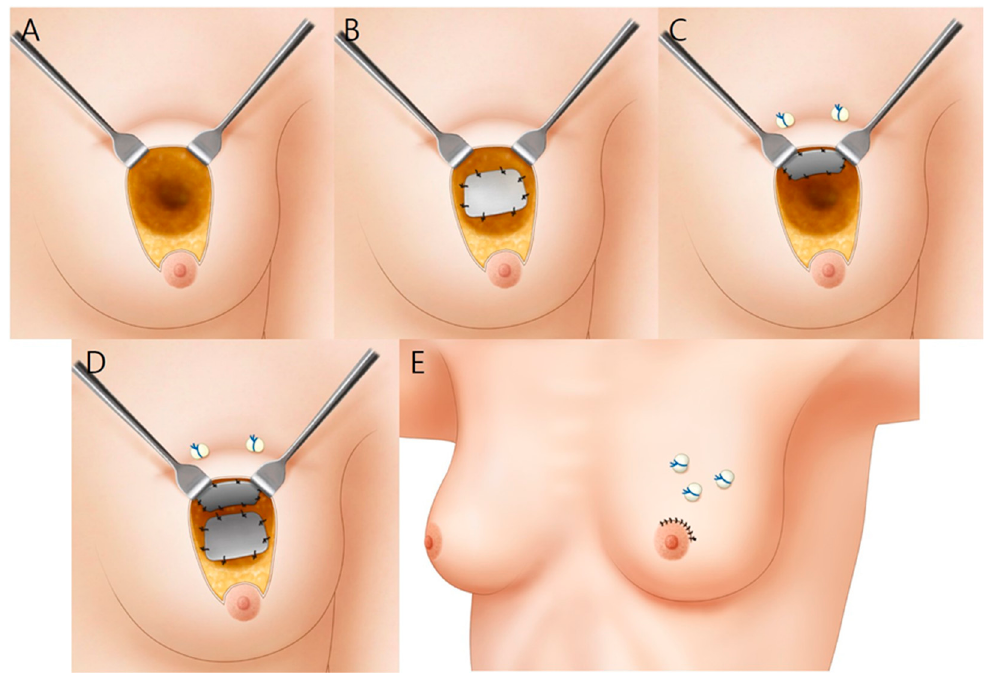
Figure 1. A schematic illustration summarizing the surgical procedure. ( A ) The glandular tissue is exposed after partial mastectomy; ( B ) An ADM is placed on the glandular flap and sutured; ( C ) An ADM is placed under the skin flap and fixed using the pullout suture technique with Prolene ® 2-0 sutures and bolsters; ( D ) The ADM graft is performed in two layers; ( E ) The suture is completed.